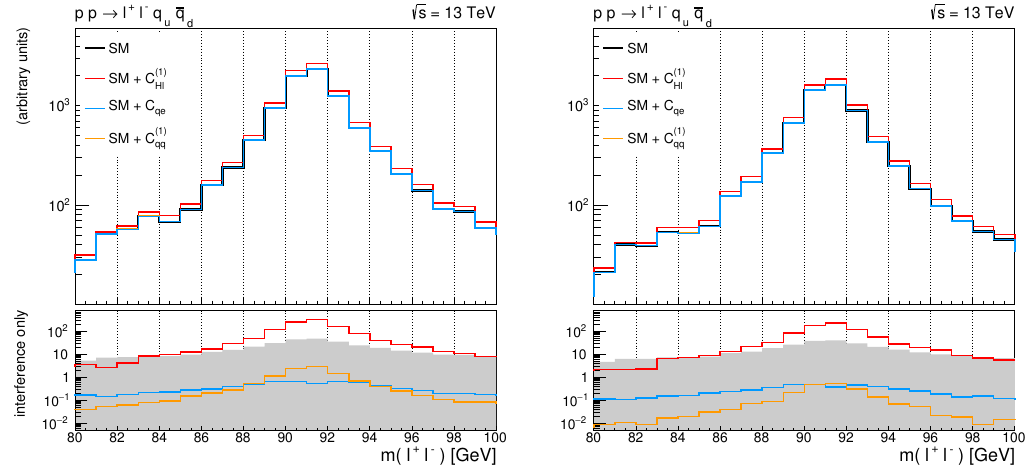
Figure 8 . Invariant mass spectrum of the ‘ + ‘ (cid:0) pair in process (iii) before (left) and after (right) applying a narrow selection cut on m ( q u (cid:22) q d ) to isolate the W + peak. The top panels show the complete distributions obtained in the SM limit and in the presence of one e(cid:11)ective operator with C i = (cid:3) 2 = 1 TeV (cid:0) 2 (only the interference term is retained in these cases). The black, yellow and blue lines are overlapping in both (cid:12)gures. The lower panels show the absolute size of the pure SM{ interference term for each operator (colored lines) compared to the statistical uncertainty on the SM distribution (grey band).